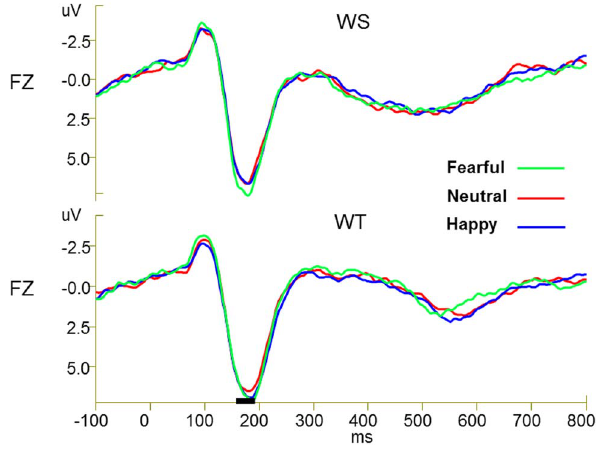
Figure 1. Grand-average ERPs by six conditions at FZ. Grand- averaged event-related potential waveforms elicited by fearful, neutral, and happy faces respectively during performance of word structure tasks (WS) and word tone tasks (WT) at FZ